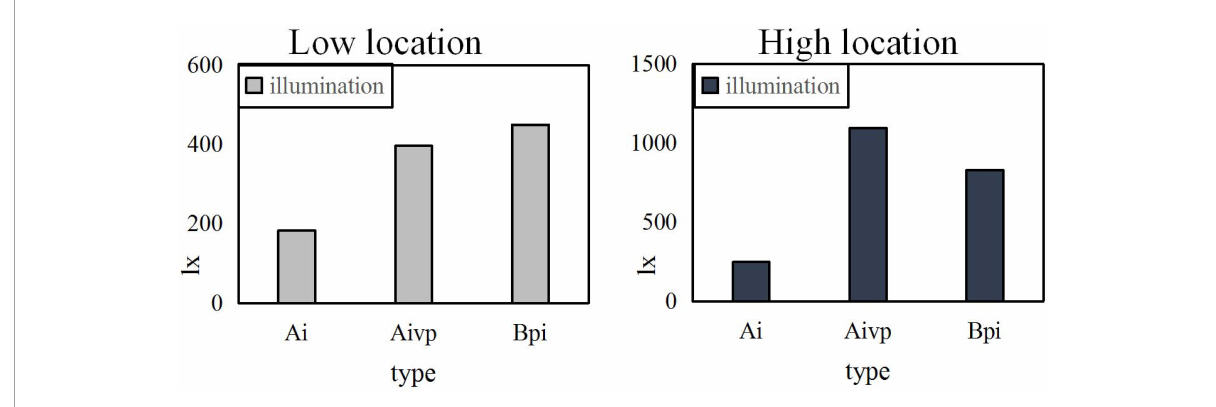
FIGURE6 The illuminance contrast of the position when the uniformity U0 is 0.3.